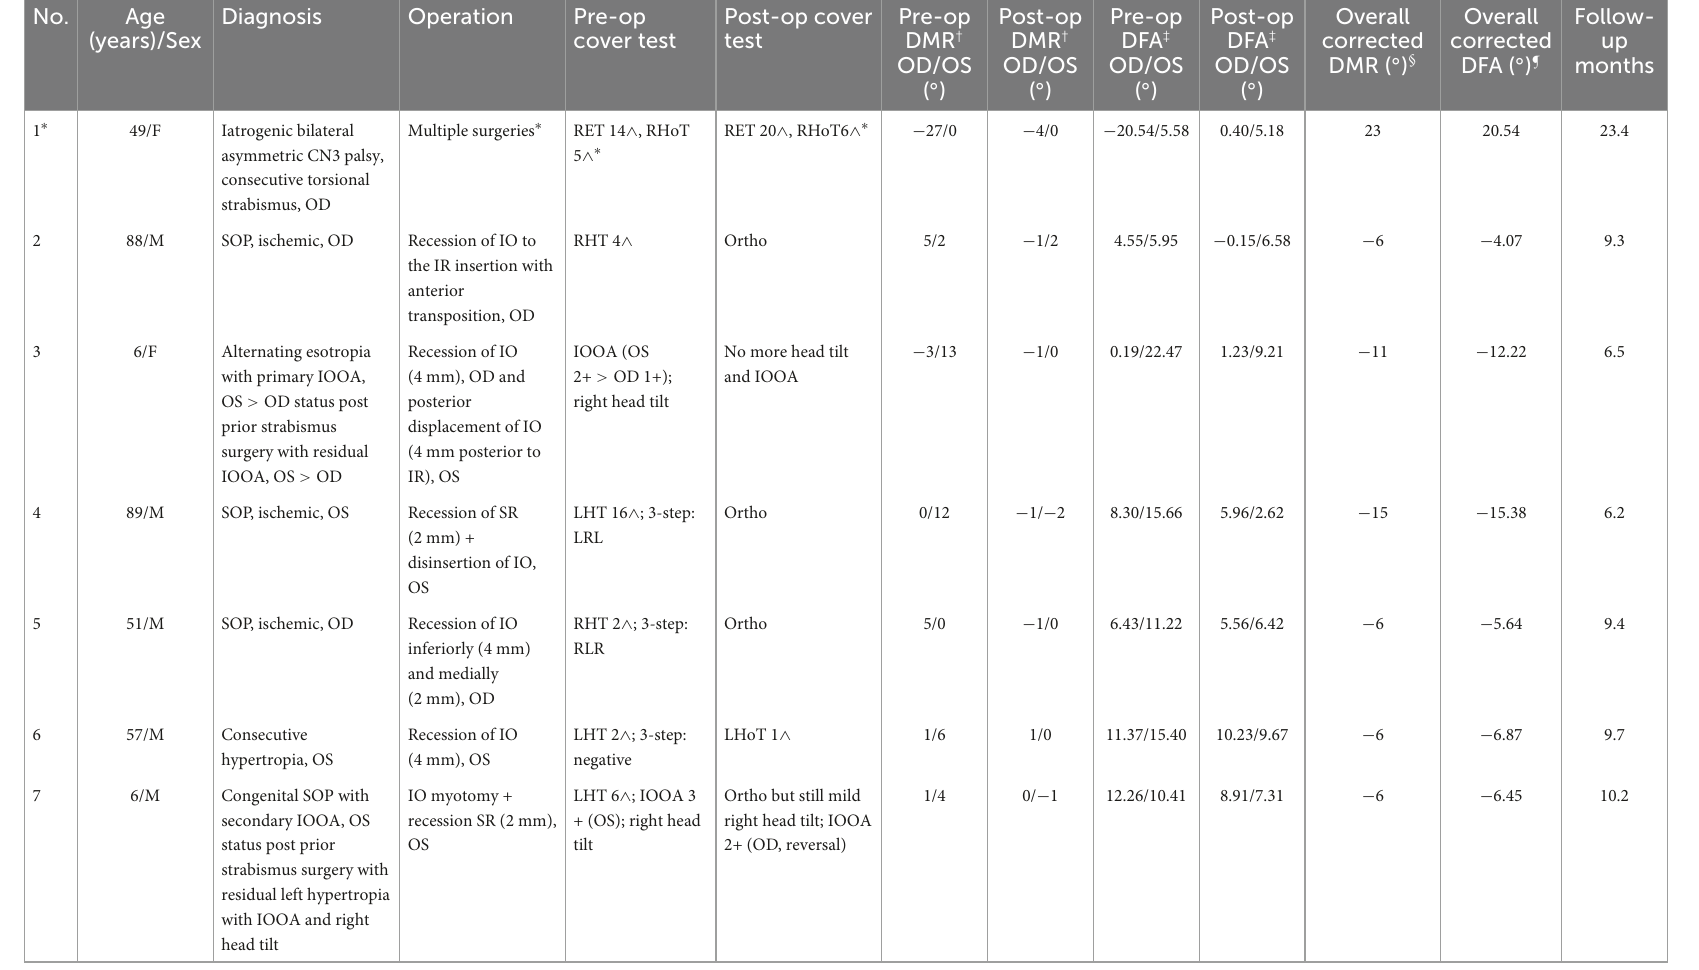
TABLE 1 Summarized torsional